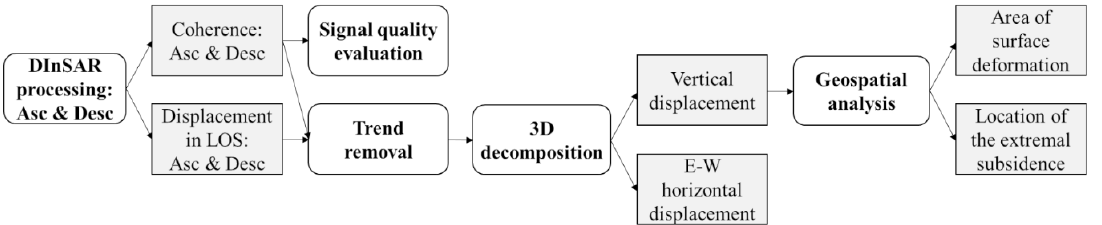
Figure 1. Differential satellite radar interferometry (DInSAR) processing and post-processing flow.